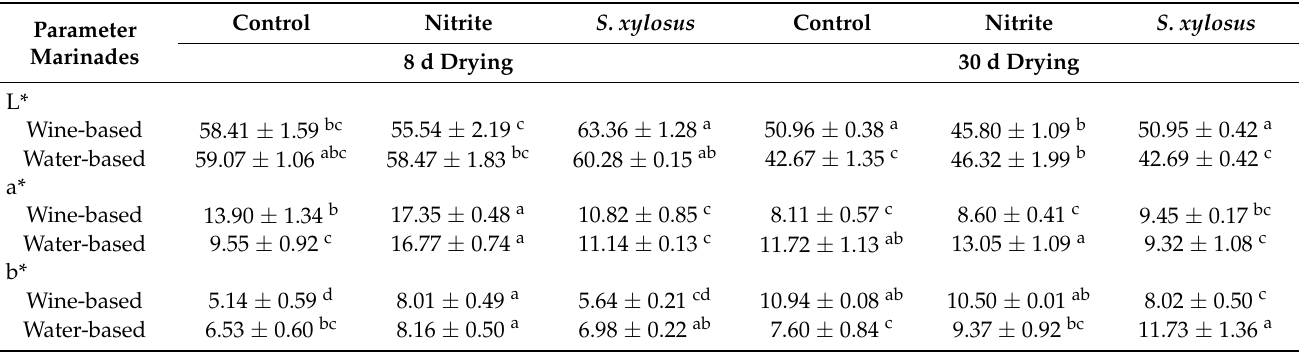
Table 6. Color parameters (L*a*b*) of cured loins after 8 and 30 d of drying. Results are presented as the mean ± standard